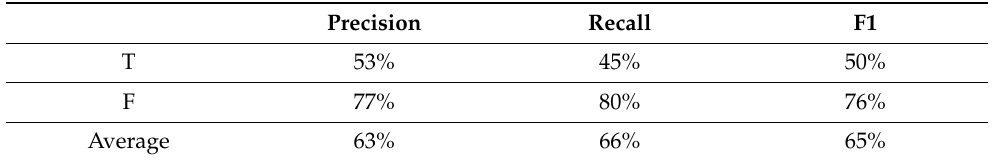
Table 7. The results as provided by the Random Forest algorithm, excluding any non-topical features (i.e., only using topical